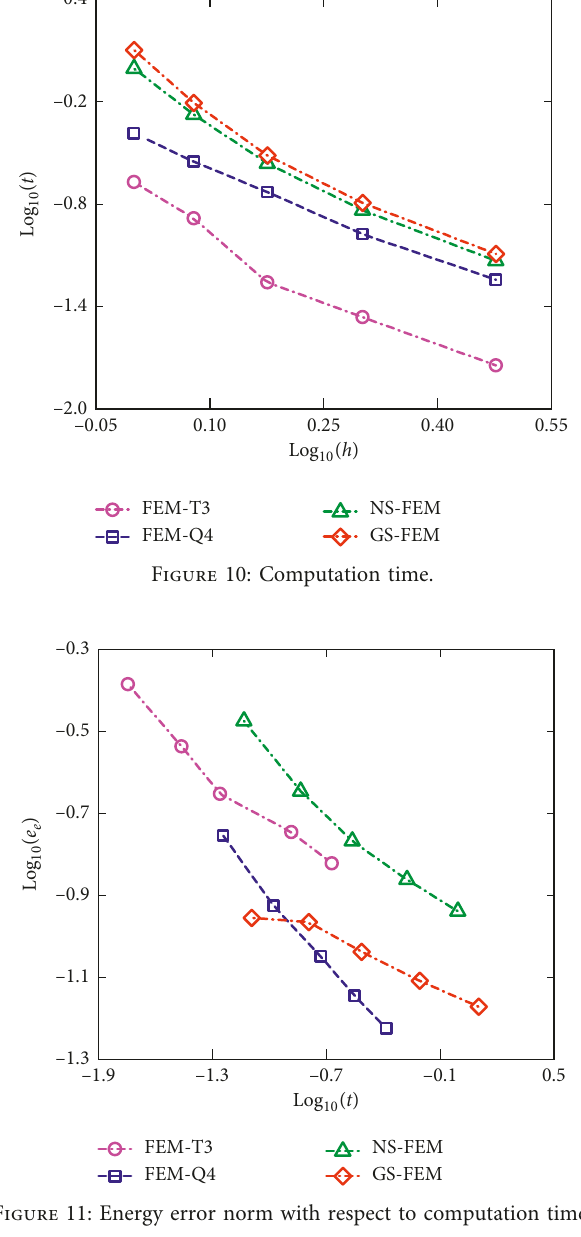
Figure 11: Energy error norm with respect to computation time.